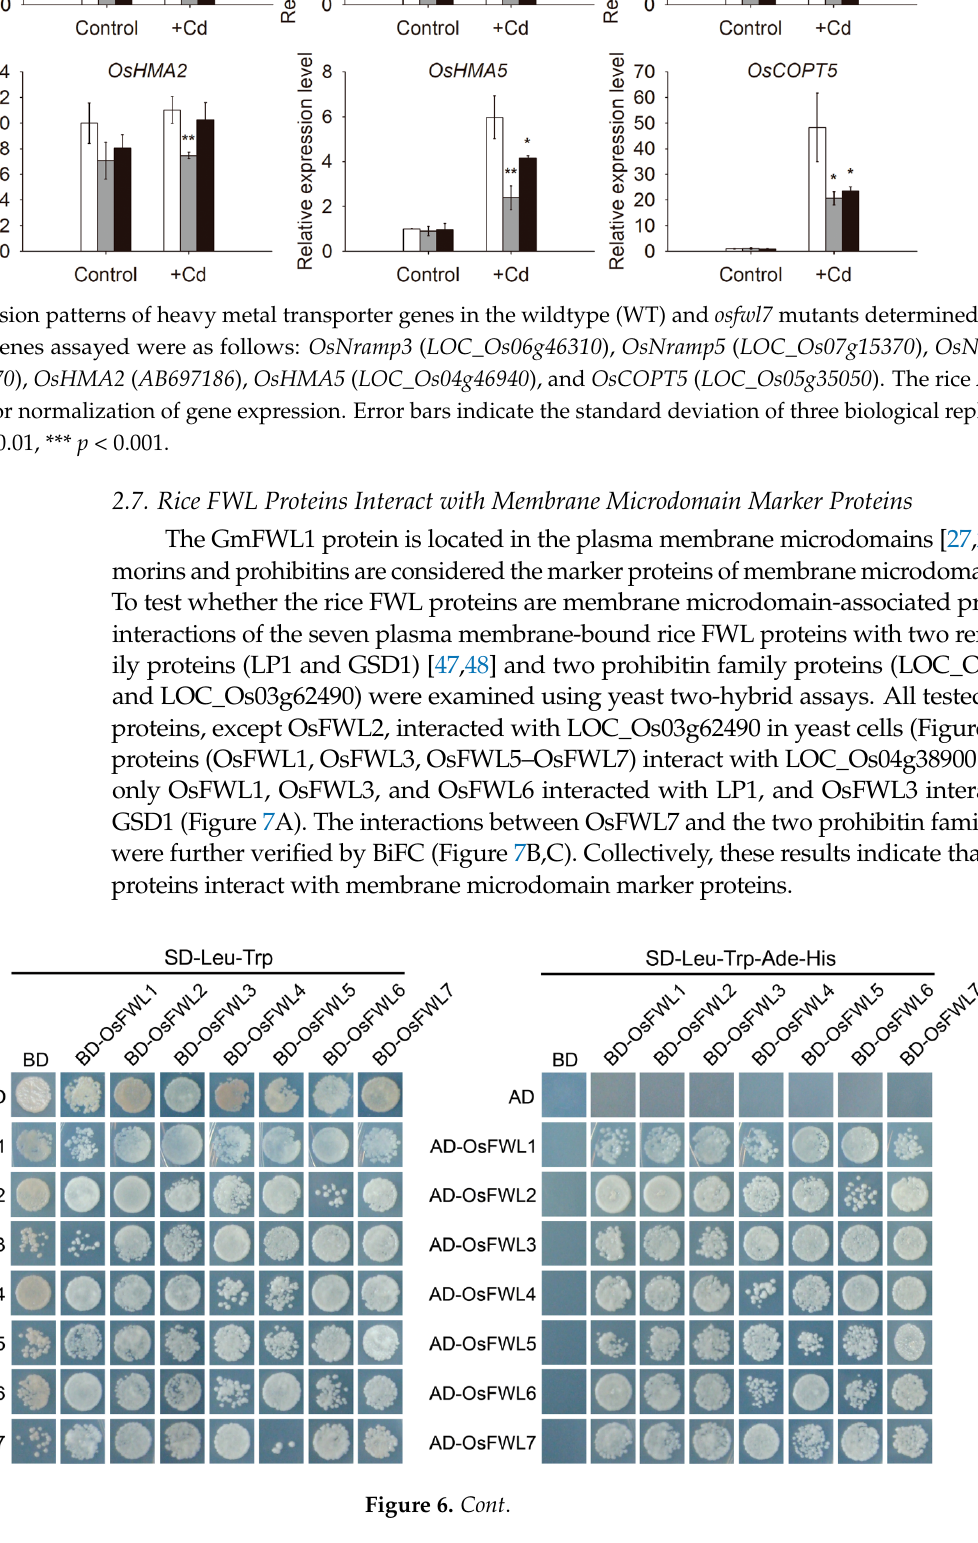
Figure 6. Detection of the interactions of rice FWL proteins. ( A ) Yeast two-hybrid assays showing that all tested rice FWL proteins interact with themselves and one another. Transformed yeast cells were cultured on SD-Leu-Trp control medium and SD-Leu-Trp-Ade-His selective medium. Yeast strains containing the OsFWL-BD and empty pGADT7 vectors, the OsFWL-AD and empty pGBKT7 vectors, or the empty pGADT7 and pGBKT7 vectors were used as negative controls. AD, activation domain; BD, DNA binding domain. ( B ) Bimolecular fluorescence complementation (BiFC) assays showing self- interaction of OsFWL7 in leaf epidermal cells of Nicotiana benthamiana . The OsSCAMP1 protein was fused with mCherry and used as the plasma membrane marker. The YFP fluorescence, mCherry fluorescence, bright field, and merged images are shown. Bar = 50 μ m.